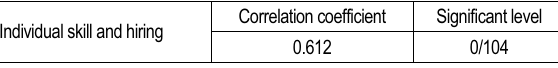
Table 4. Spearman correlation coefficient test